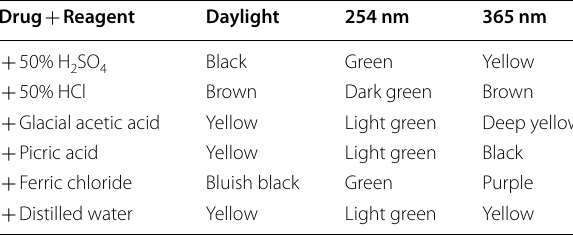
Table 6 Fluorescence analysis of Costus afer Drug Reagent +